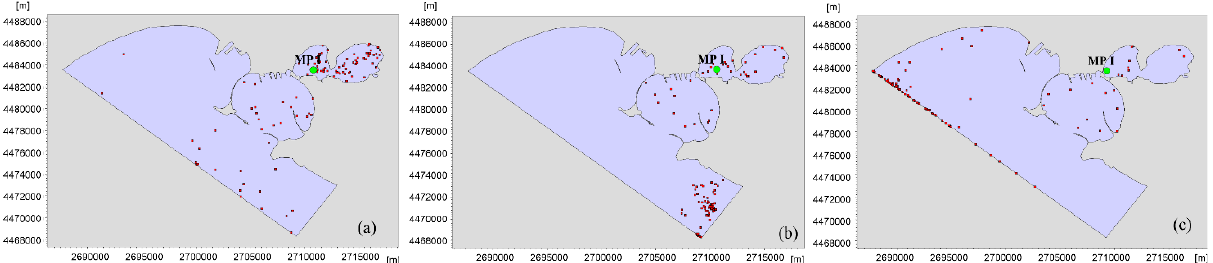
Figure 15. Percentage PT3 (MG3) — the cloud of particles: ( a ) 30 days after release; ( b ) 60 days after release; ( c ) 90 days after release at bottom layer.